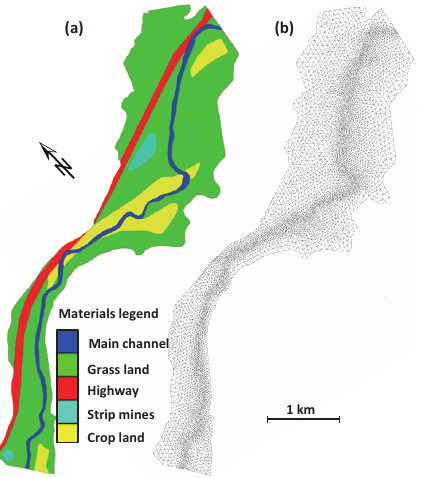
Figure 2. The land-use information (a) and finite element mesh (b) of the study area.